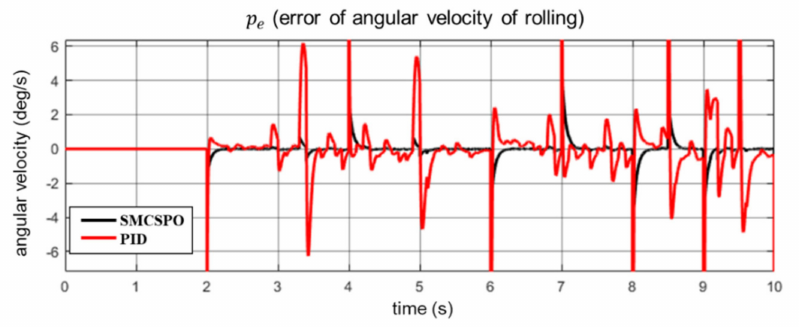
Figure 9. SMCSPO control simulation results with small disturbances (variance of magnitude = 0.1).